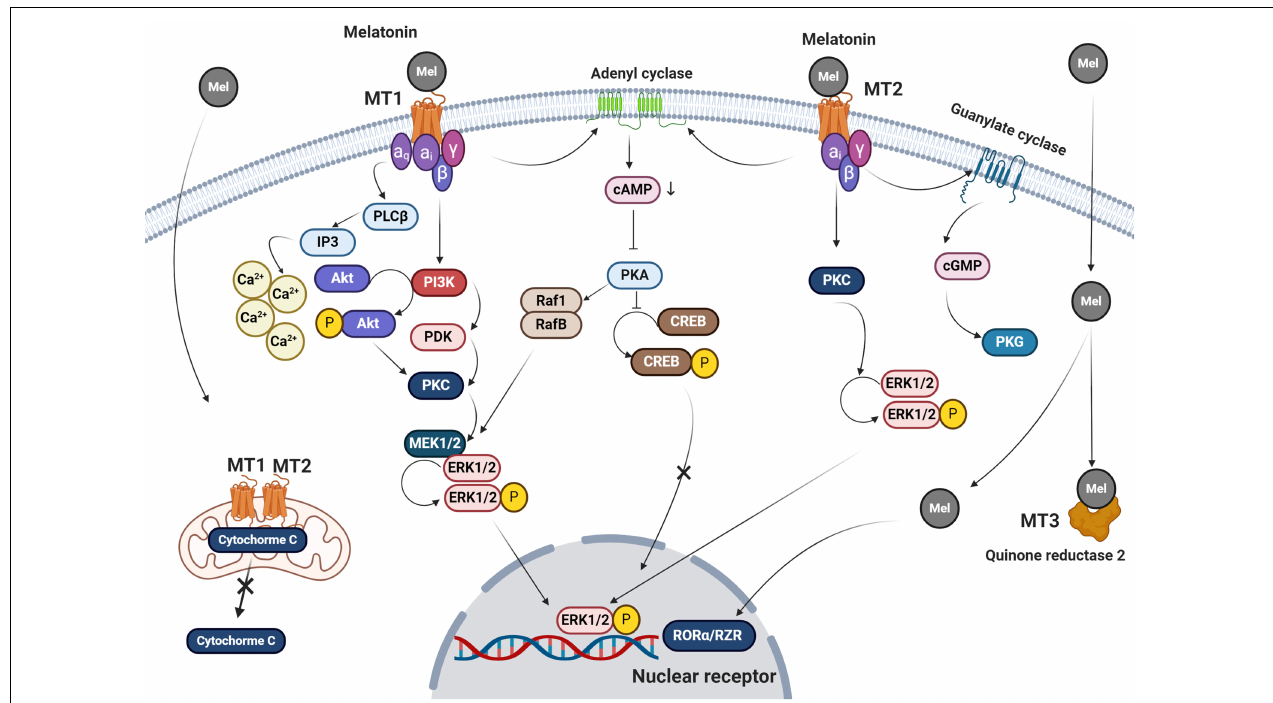
FIGURE 3 | Melatonin signaling pathways are summarized in this figure. Both MT1 and MT2 belong to the GPCRs family of receptors. Melatonin also crosses the plasma membrane via passive diffusion. Upon the attachment of melatonin to MT1 and MT2, different effectors including PKC, PLC β , and PKA are recruited as second messengers to trigger downstream signaling pathways. For subsequent events, the melatonin-MT1 complex linked α q , α i , β , and γ subunits to activate IP3 and intracellular accumulation of Ca + 2 after its release from the endoplasmic reticulum. Ca + 2 phosphorylates both PKC and ERK1/2. MT1 receptor also acts through membrane adenyl cyclase, which blocks the phosphorylation of CREB by activation of cAMP and PKC. Melatonin binding to MT2 activates the adenyl cyclase and leads to CREB inactivation. Melatonin promotes conformational changes in MT2 and activation of α i subunit leads to stimulation of PKG via guanylate cyclase. Also, MT2 engages PKC and ErK1/2 complexes. Melatonin crosses the plasma membrane via passive diffusion and transporters and activates both mitochondrial MT1 and 2 thereby reducing the escape of cytochrome C into the cytosol. Other possible melatonin receptors include cytosolic quinone reductase 2 which activates nuclear ROR α /RZR. Mel, melatonin; cAMP, cyclic adenosine monophosphate; cGMP, cyclic guanosine monophosphate; MT, melatonin receptor; PKC, protein kinase C; PKA, protein kinase A; CREB, cAMP response element-binding protein; IP3, inositol trisphosphate; and PDK, pyruvate dehydrogenase